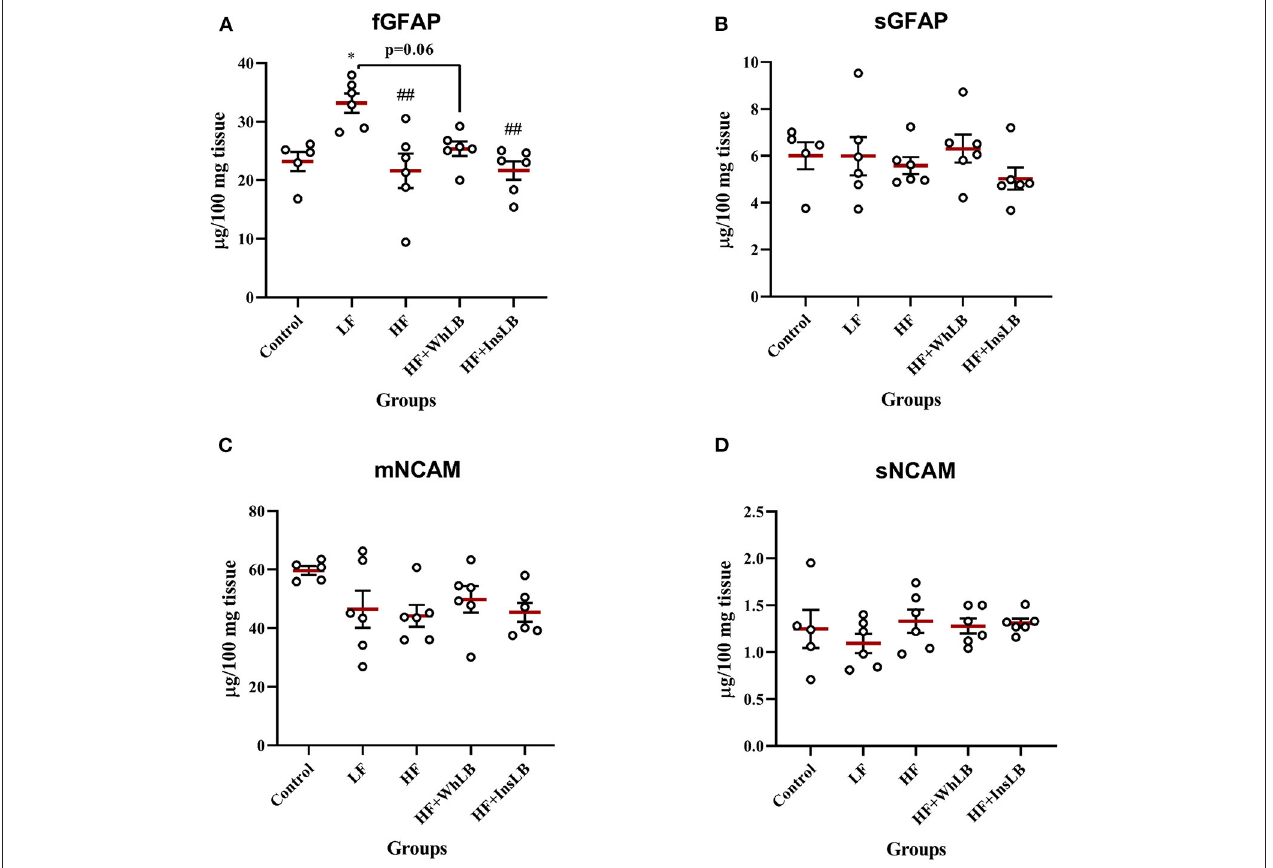
FIGURE 6 | The levels of astrocyte- and neuron-specific proteins in the hippocampus of ApoE–/– mice. The concentrations of (A) the filamentous and (B) the soluble forms of GFAP, as well as (C) the membrane and (D) the soluble forms of NCAM are presented in the form of the scatter dot plots. Data are expressed as the Mean ± SEM ( n = 5–6/group). Comparisons among groups were performed with the one-way ANOVA, followed by Turkey’s post hoc test. * p < 0.05 indicates significant difference vs. control; ## p < 0.01 indicates significant differences vs.